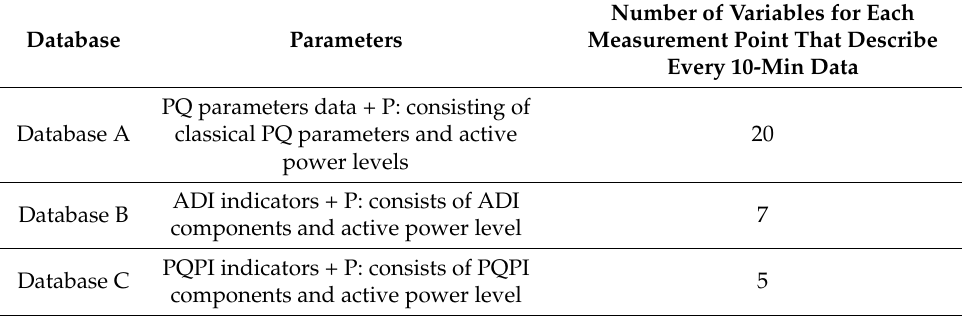
Table 1. Description of input